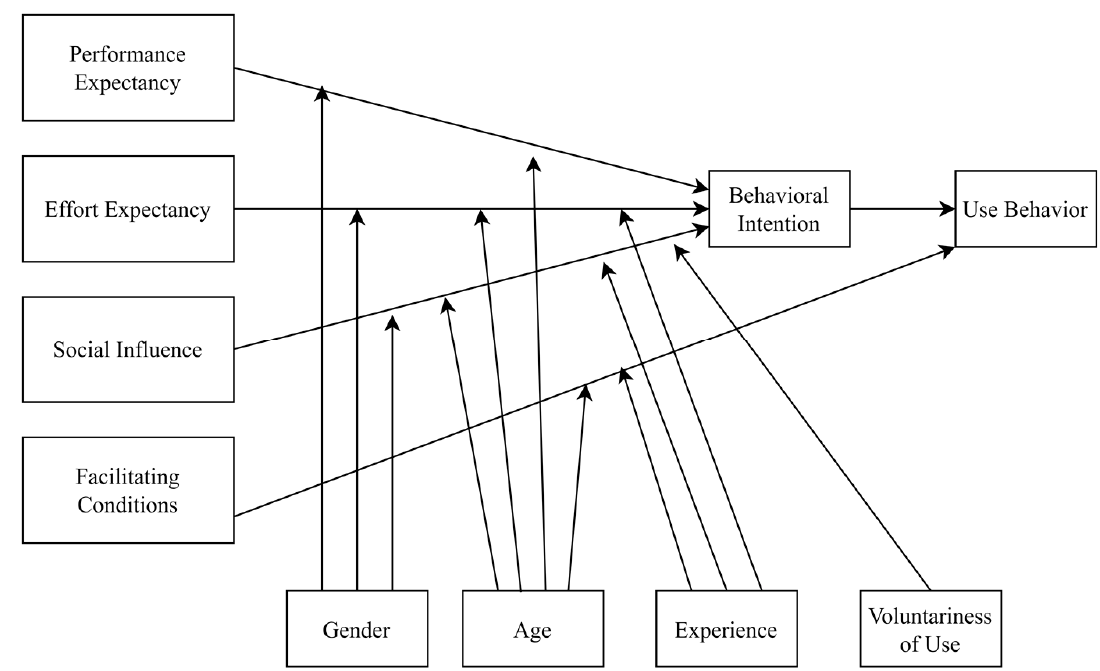
Figure 2. UTAUT Model (Venkatesh, Morris, Davis, and Davis, 2003).